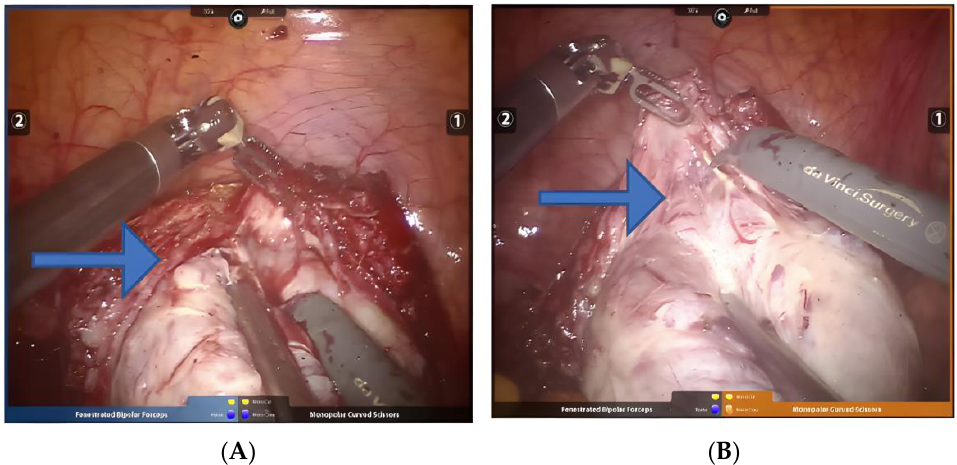
Figure 7. ( A , B ) Resection of myomatous with degeneration. Arrows point to the space between the degenerated fibroids and the myometrium.